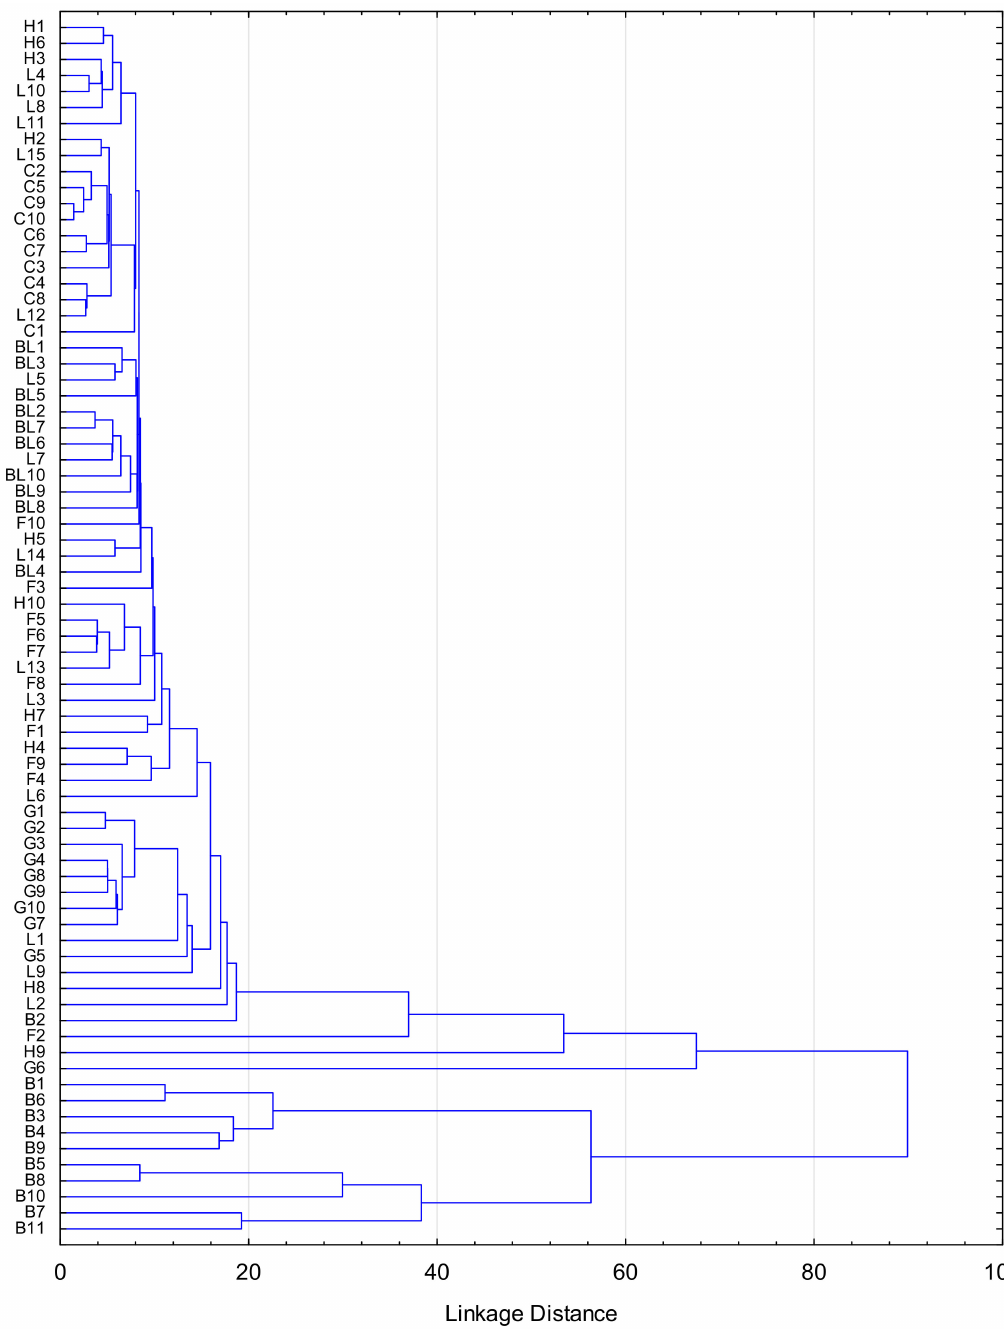
Figure 3. Dendrogram of di ff erent Polish unifloral honeys according to cluster analysis of similarity on the basis of the major compounds content (uridine, tyrosine, phenylalanine). H1-10—heather; B1-10—buckwheat; BL1-10—black locust; G1-10—goldenrod; C1-10—canola; F1-10—fir;